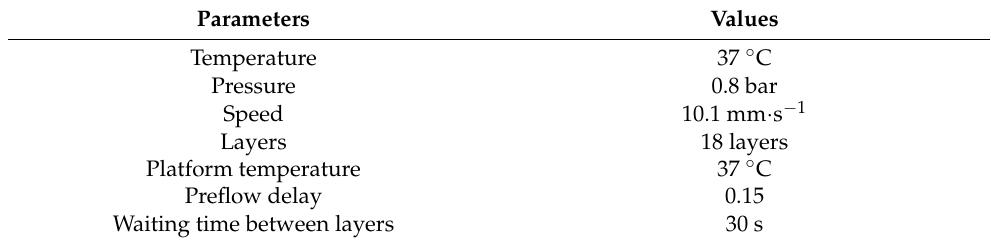
Table 2. Modified parameters were used for the 3D printing of the biomaterial